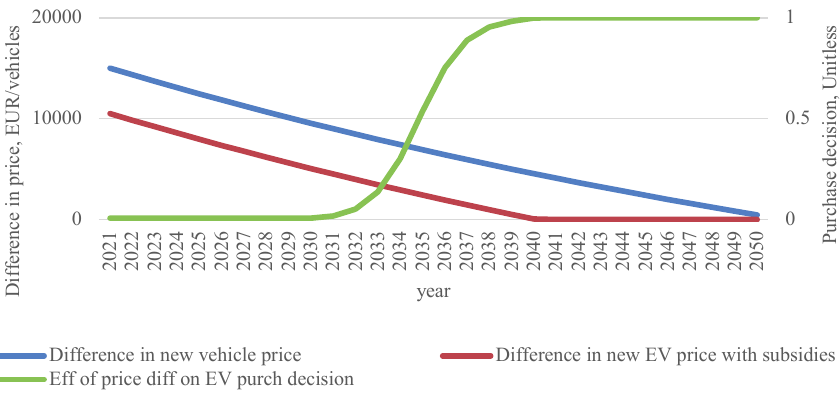
Fig. 4. Price difference effect on EV purchase